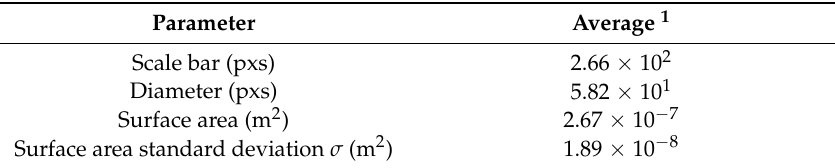
Figure 7. A sample of CerexCuIv4 (coated non-woven fabric) ( a ), and detail of the sample structure ( b ). Table 2. Results for the handmade selection method.